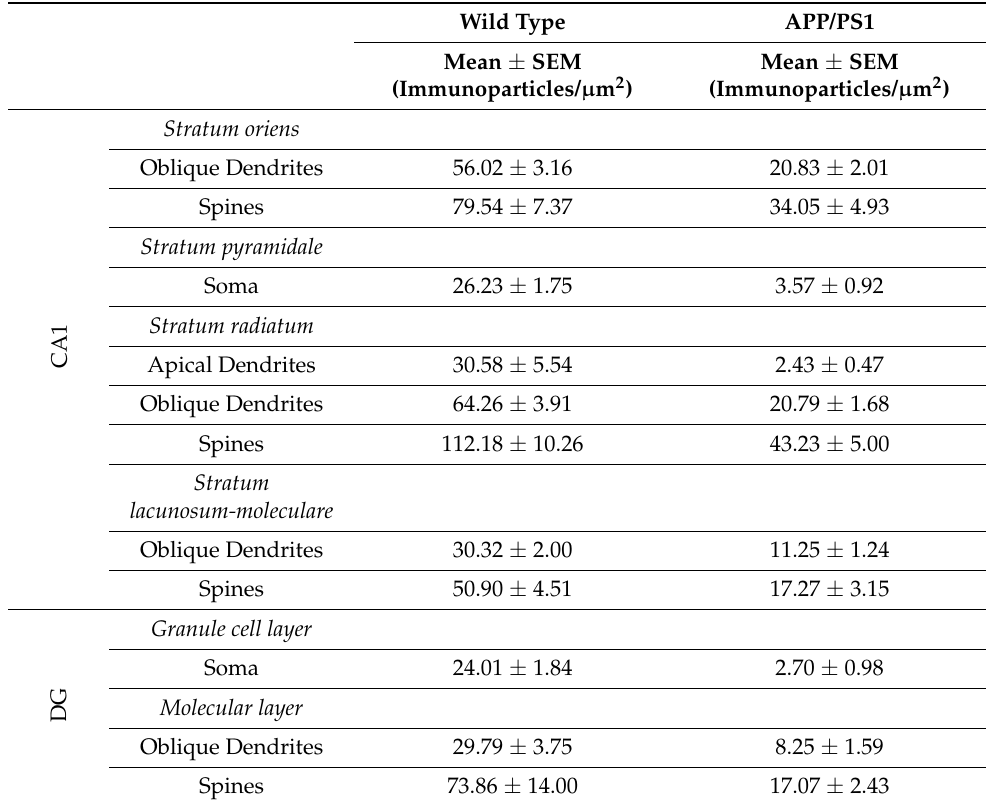
Table 1. Distribution of mGlu 5 immunoparticles along the membrane surface of CA1 pyramidal cells and DG granule cells at 12 months of